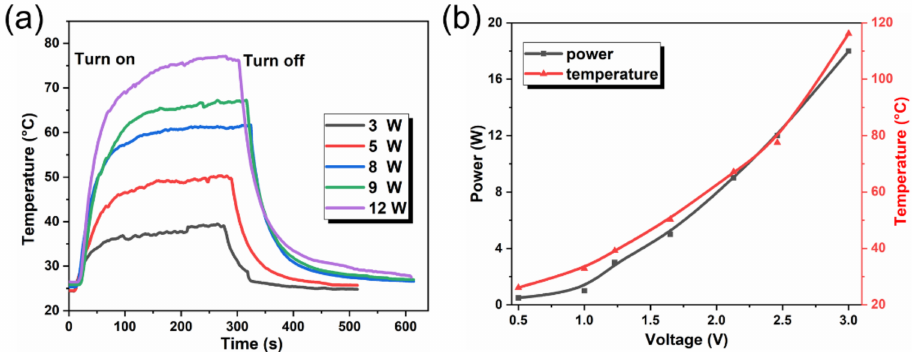
Figure 9. ( a ) The time-dependent temperature curve of PI-LM film as a function of the applied power. ( b ) The plot of temperature and power at the same